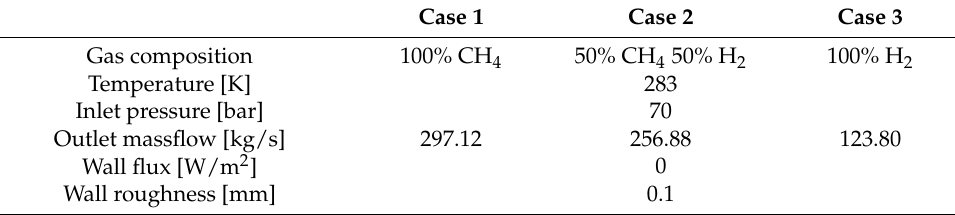
Table 4. Boundary